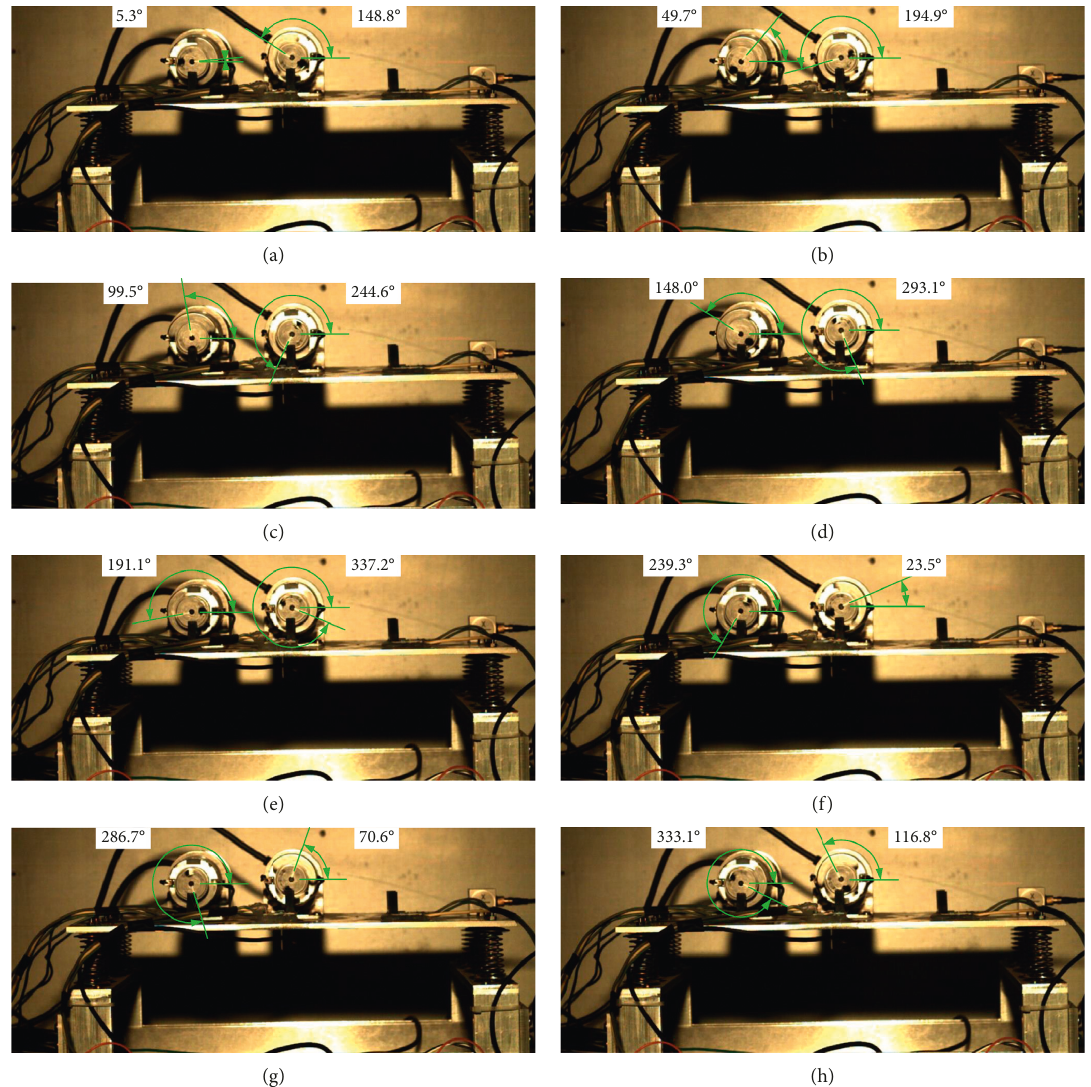
Figure 7: The phase difference of vibration synchronization of two ERs with the anticlockwise rotational direction. (a) φ